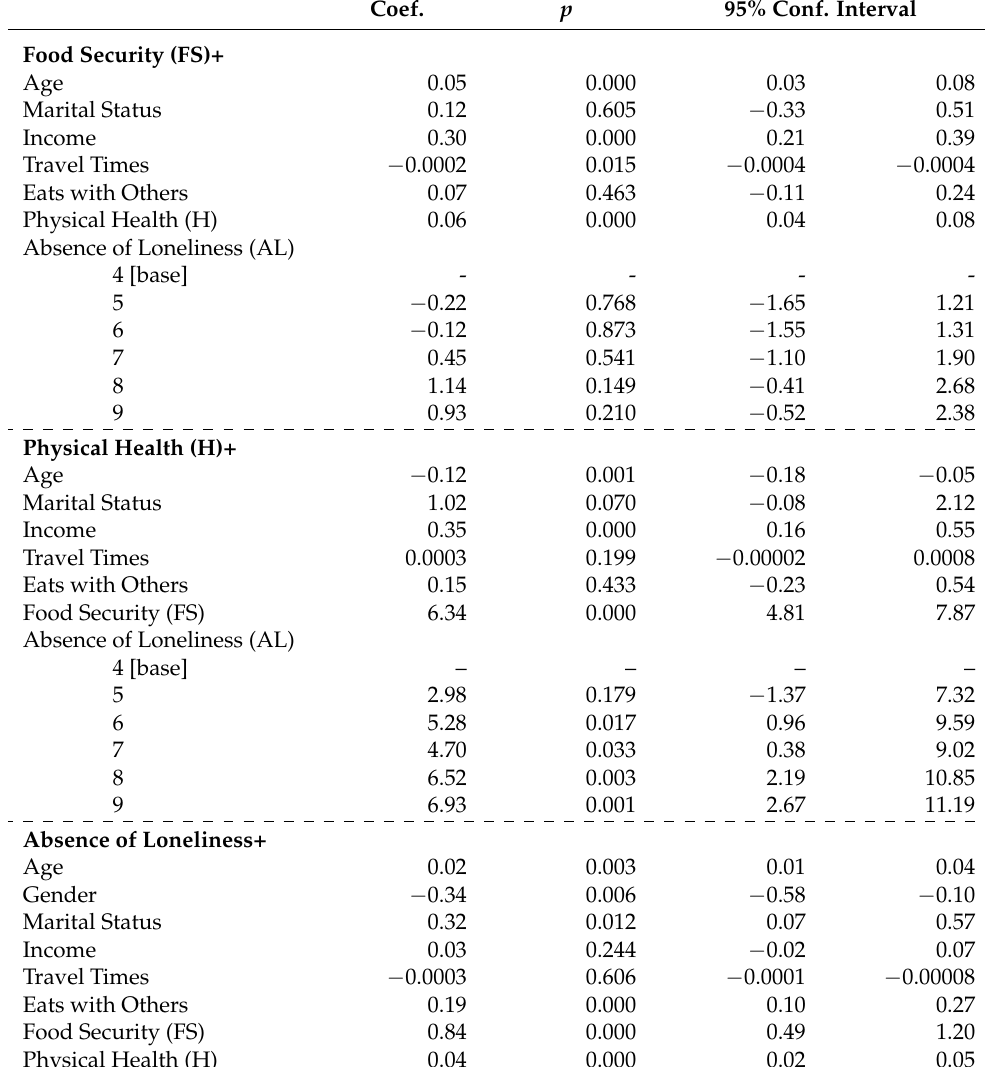
Table A2. After COVID structural equation modeling